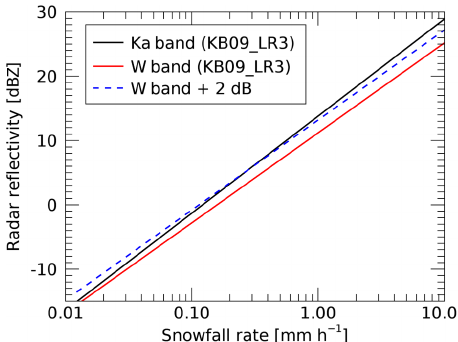
Figure 9. Radar reflectivity at Ka band (MMCR) and W band (CloudSat) as function of snowfall rate for KB09_LR3 Z – S rela- tion. The dashed blue curve has the same slope as the red curve and is provided only as a visual reference to show the slight difference in slope between the red and black